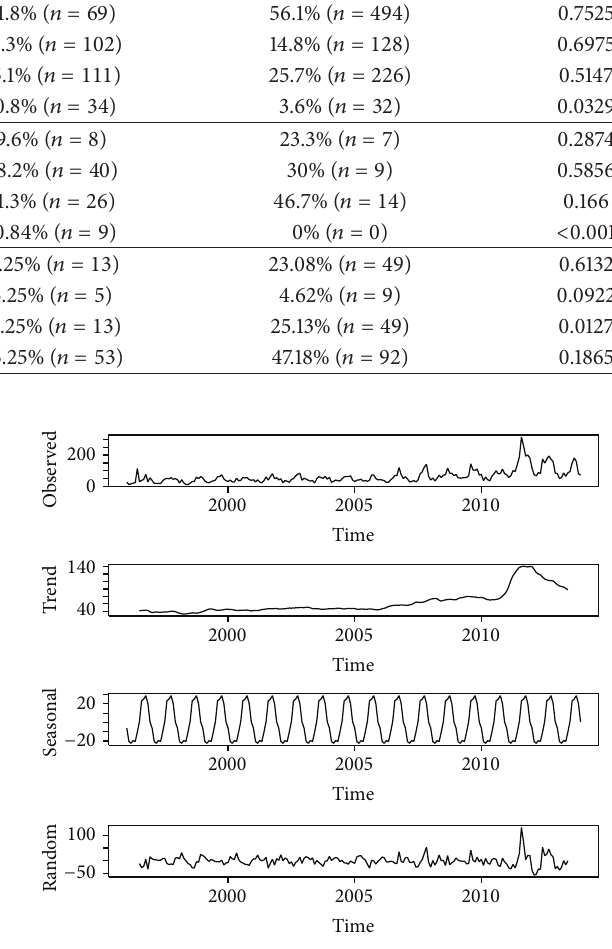
Figure 4: Decomposition of additive time series of total monthly